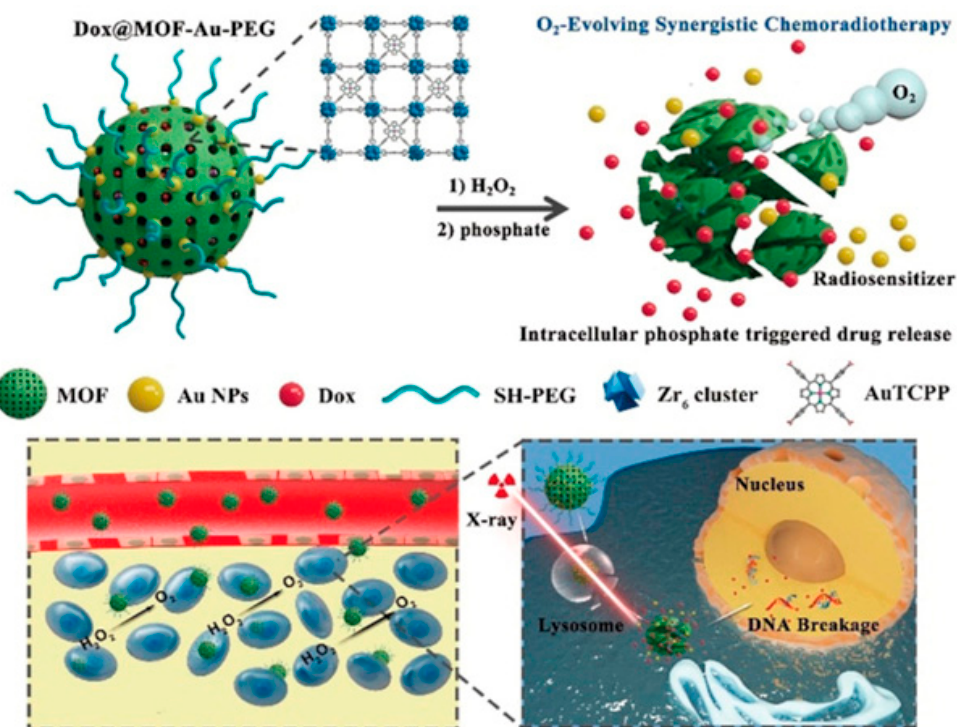
Figure 7. The structure of Dox@MOF-Au-PEG and the underlying of O 2 -generating synergistic chemoradiotherapy Reprinted with permission from Ref. [67]. Copyright 2019, Wiley-VCH Verlag GmbH & Co. KGaA, Weinheim.